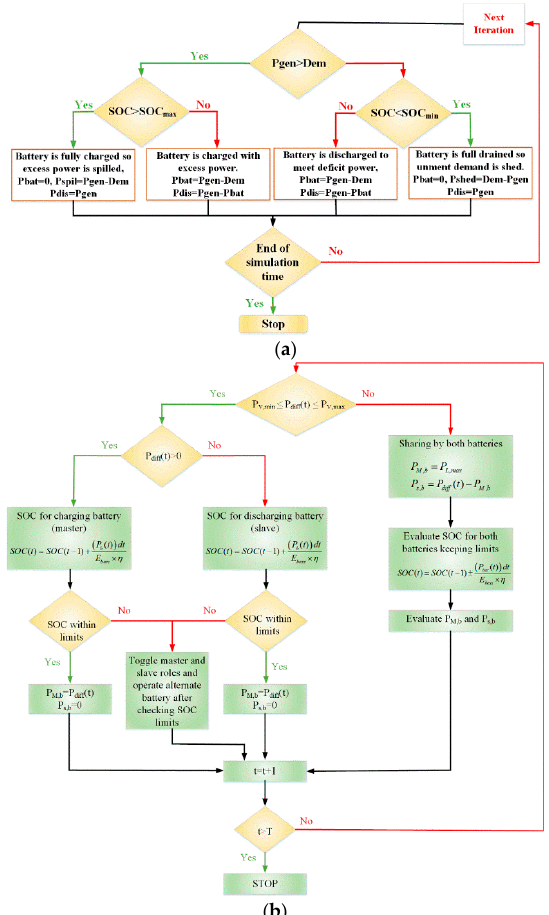
Figure 3. Flow chart for Energy Management Strategy for ( a ) Single battery case ( b ) Dual battery model case.